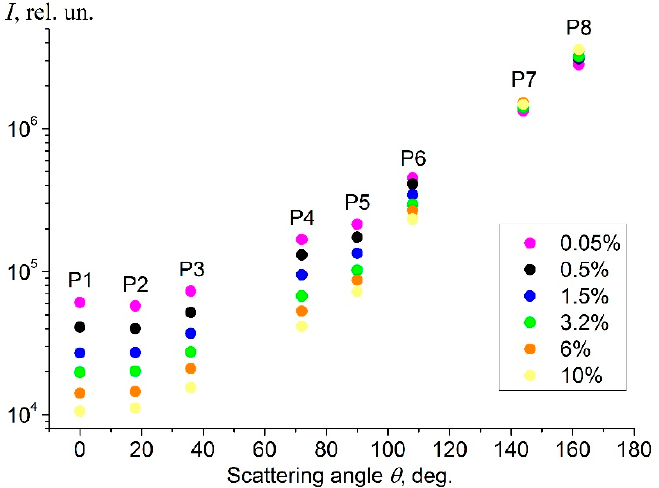
Figure 4. Scattering indicatrix measured for milk samples with a nominal fat percentage of 0.05%, 0.5%, 1.5%, 3.2%, 6%, and 10% at zero flow velocity in the tube at a temperature of 20 °C. Laser wavelength is 532 nm.